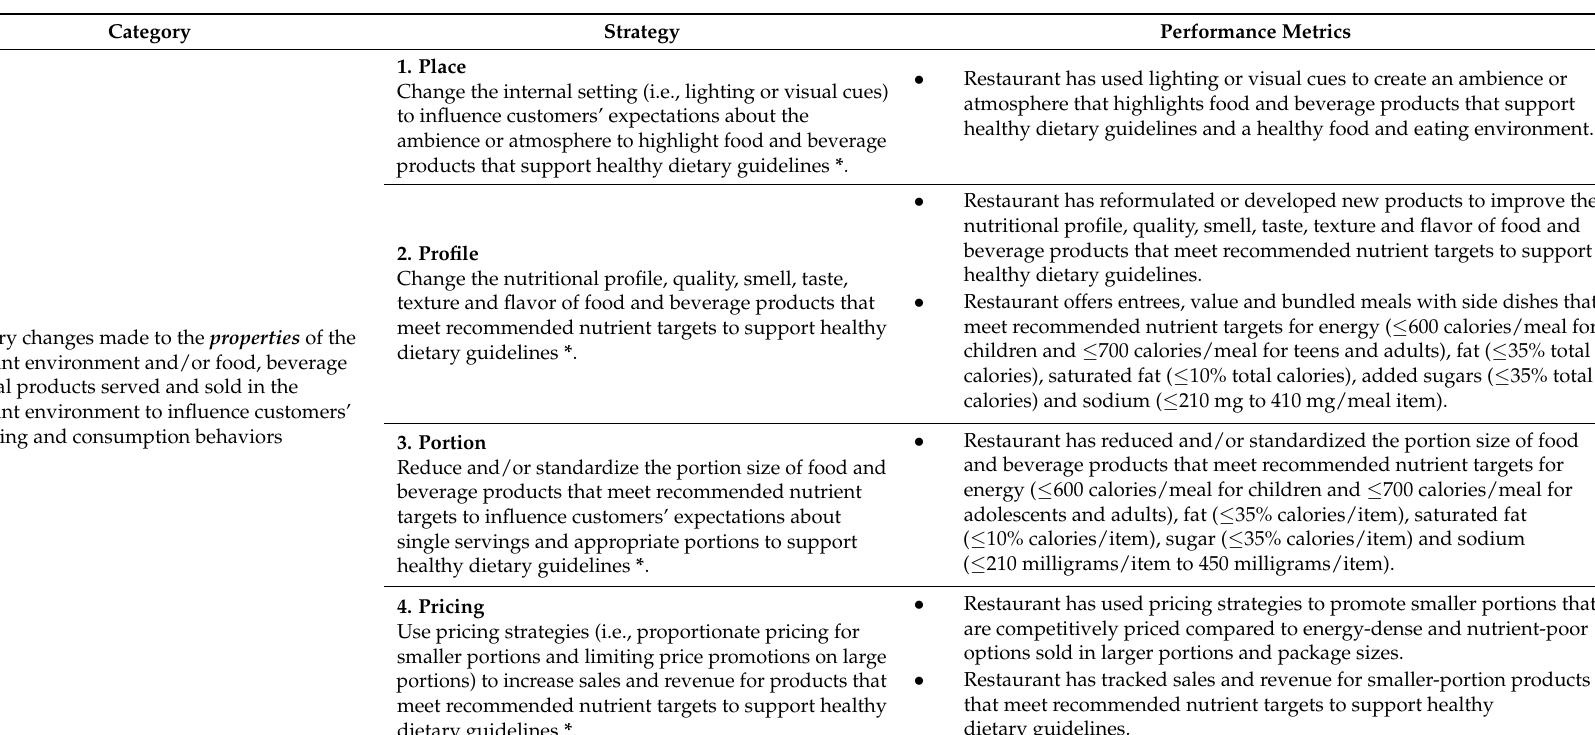
Table 1. Marketing-mix and choice-architecture framework used to evaluate U.S. restaurant-sector progress to promote healthy food environments for American children, adolescents and parents,